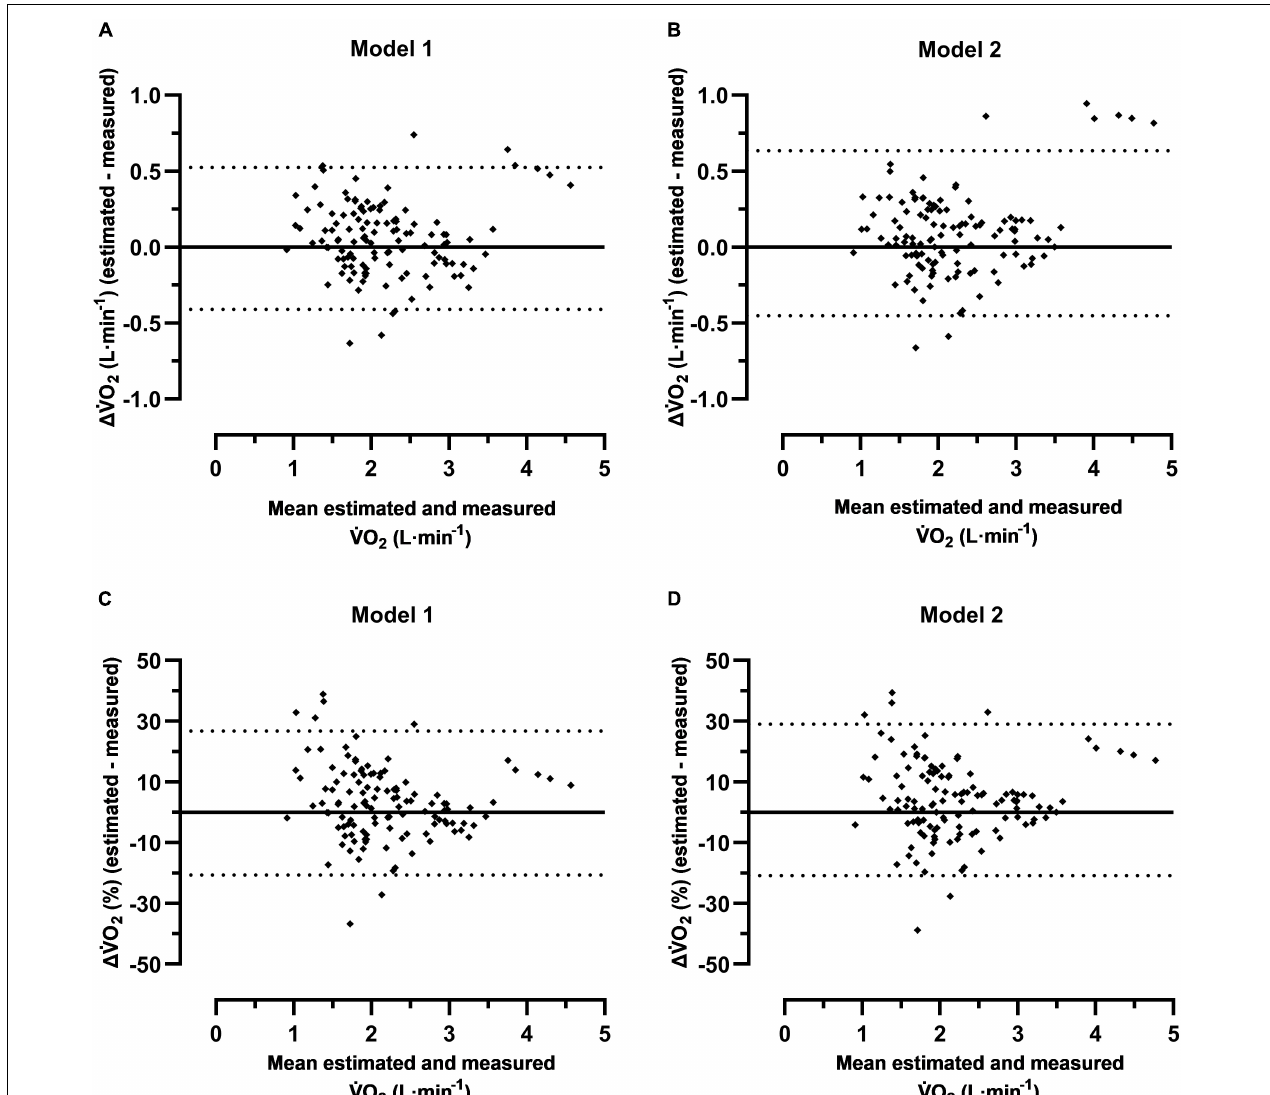
FIGURE 3 | Individual levels of differences with 95% limits of agreement (dotted lines) between the estimated and measured oxygen uptake (˙VO 2 ) at six positions of heart rate (HR) for males and females together ( n = 20) during cycle commuting. The y-axes show the absolute or the relative differences against the mean values of the estimated and measured ˙VO 2 on the x -axes for the two models; absolute differences with model 1 (A) and model 2 (B) ; relative differences with model 1 (C) and model 2 (D)